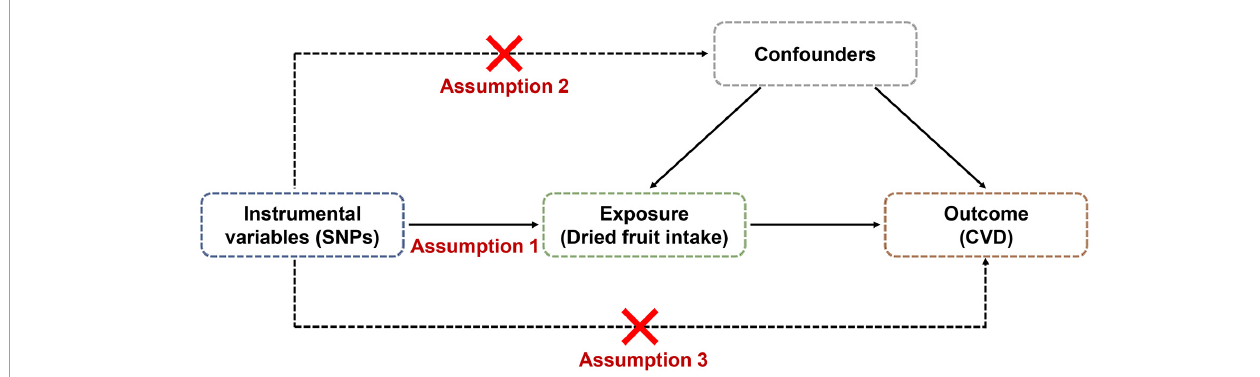
FIGURE1 Flow diagram for Mendelian randomization (MR)